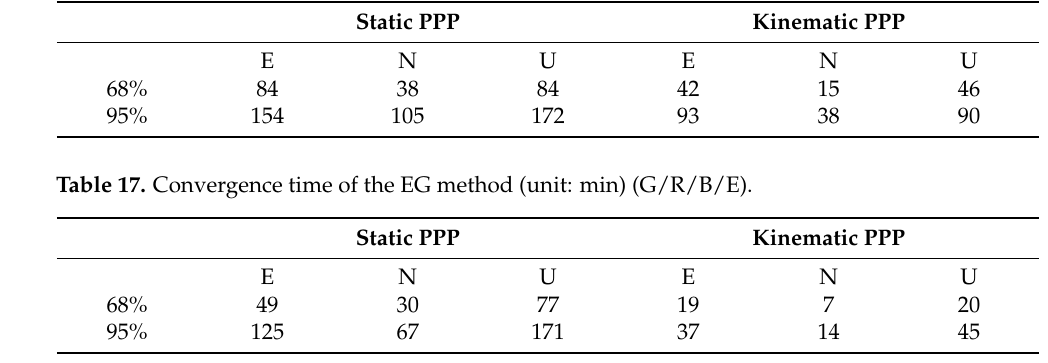
Table 18. Convergence time of the QF method (unit: min) (G/R/B/E). Static